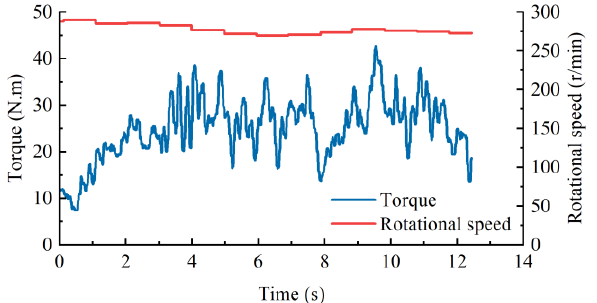
Figure 6. Time domain diagram of original torque and rotational speed